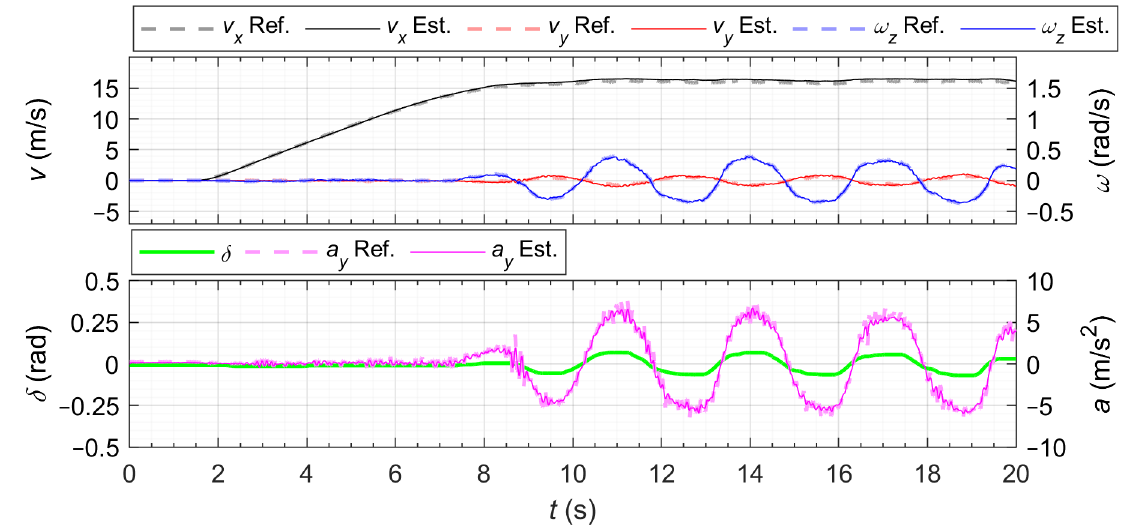
Figure 9. Test data—Slalom maneuver on a dry road surface: measured and estimated velocities, yaw rate, lateral acceleration, and steering